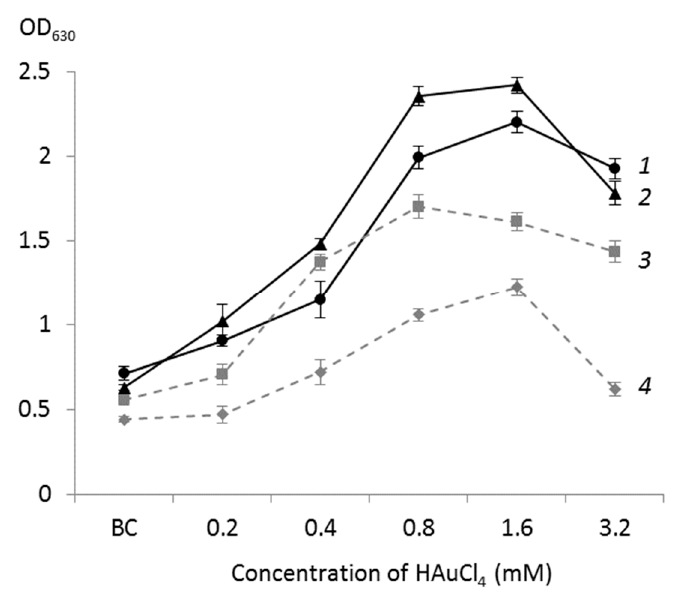
Figure 5. Biosynthesis of AuNPs (OD 630 values) by Rhodococcus spp. in the presence of different HAuCl 4 concentrations. BC—biotic control, (1)— R. ruber IEGM 1135, (2)— R. erythropolis IEGM 766, (3)— R. rhodochrous IEGM 1162, and (4)— R. fascians IEGM 525.